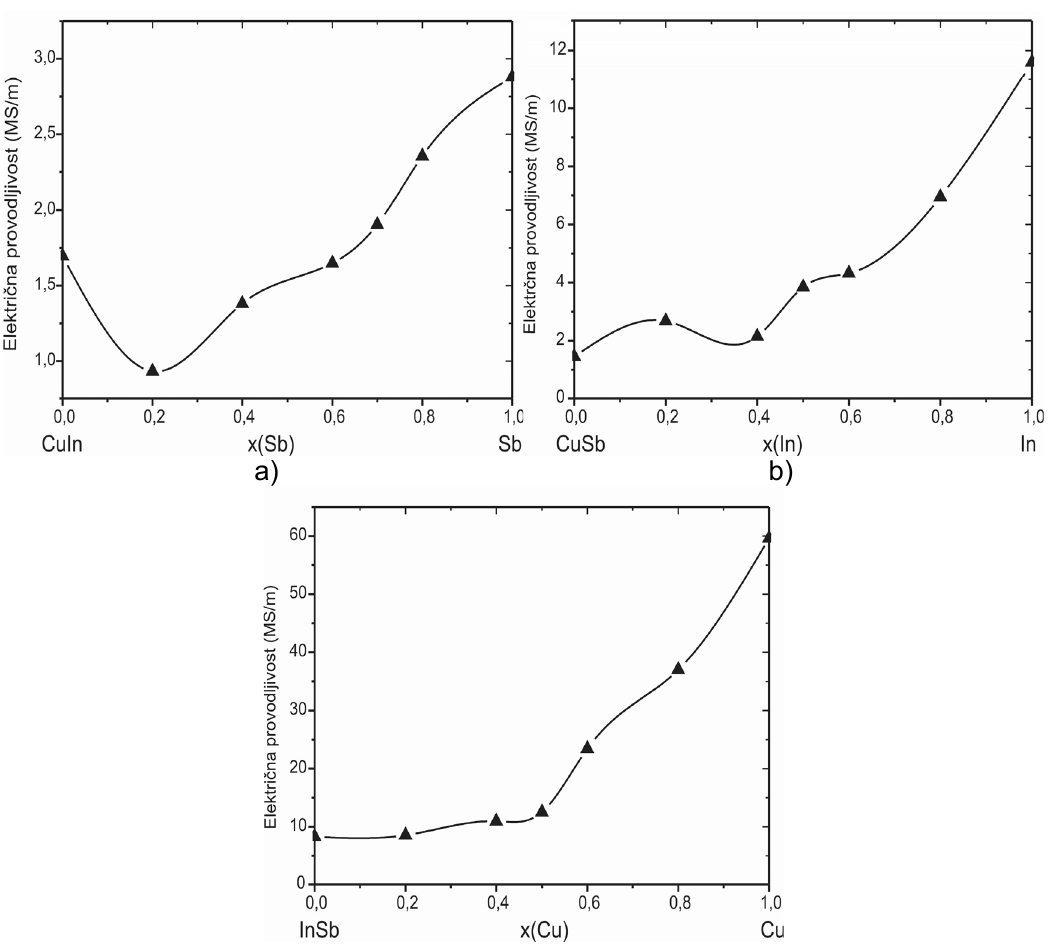
Figure 5. Electric conductivity of ternary Cu-In-Sb system, a) vertical Sb-CuIn section, b) vertical In-CuSb section and c) vertical Cu-InSb section.